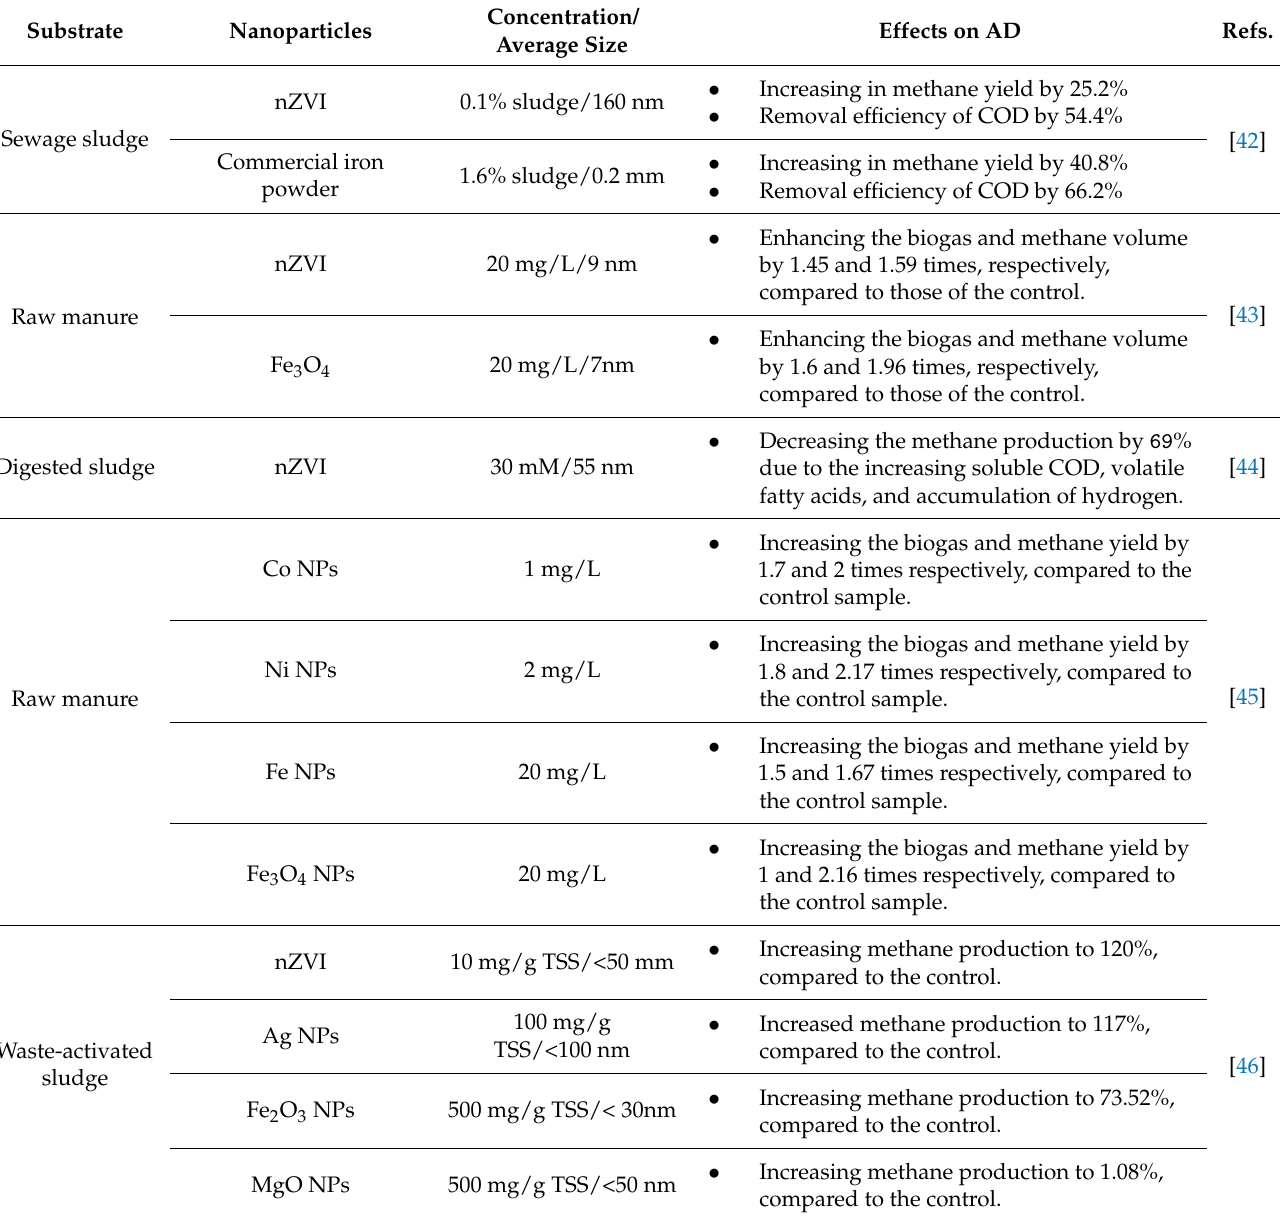
Table 1. Effects of various nanoparticles (NPs) in the forms of nano zero valent iron (nZVI), metal oxides, carbonaceous, and multi-compound on AD